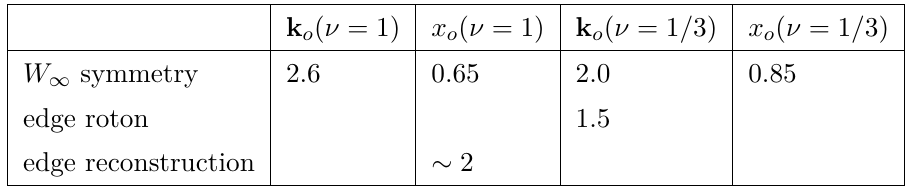
√ m for filling ν = 1 /m